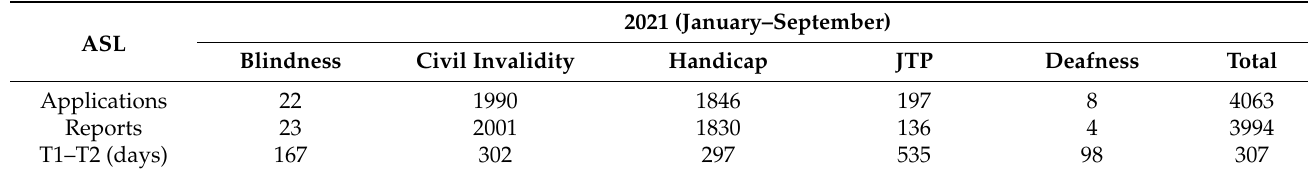
Figure 3 – Iglesias: distribution of total applications and ASL reports 2021 (January-September)